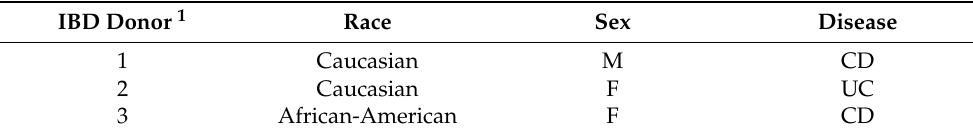
Table 1. IBD stool donor patient characteristics.